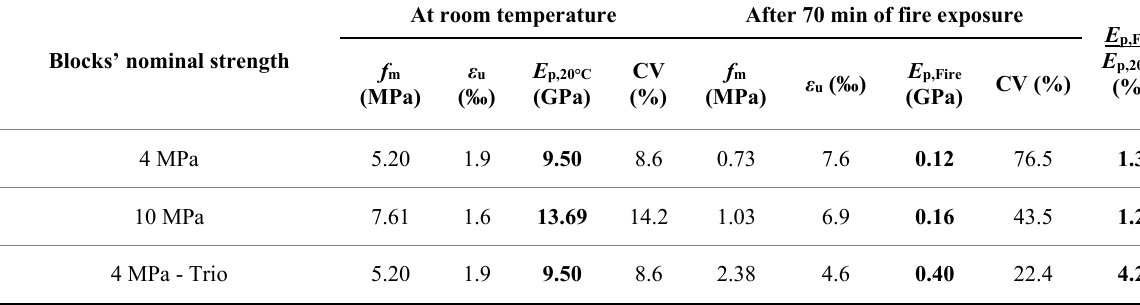
At room temperature After 70 min of fire exposure E p,Fire E p,20°C f m ε u E p,20°C f m E p,Fire CV ε u (‰) CV (%) (%) (MPa) (‰) (GPa) (%) (MPa) (GPa)